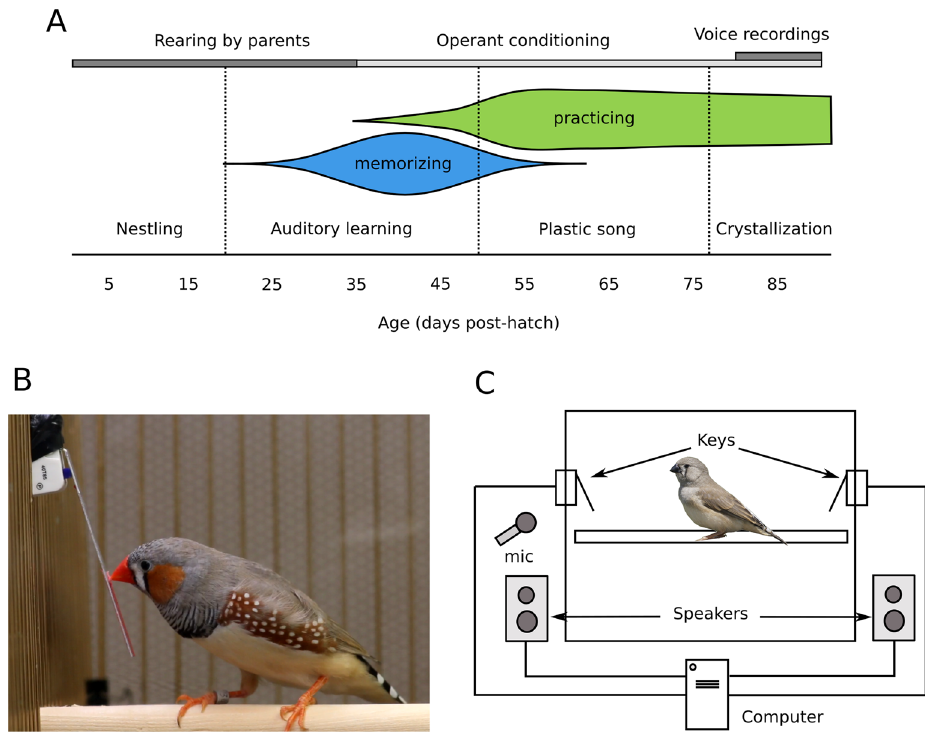
Figure 1. Experimental set-up. ( A ) Experimental timeline (top) and developmental trajectory of song learning in male zebra finches. Zebra finches were reared by their parents in a room where they could also listen to, but not see, adult male zebra finches other than the father (“neighbors”). At 35–37 dph, when finches are nutritionally independent 37 , the juveniles were transferred to an operant chamber equipped with keys that were associated with playback of father’s or neighbor’s song. Preference for father’s or neighbor’s song was measured daily while the bird remained in the operant chamber, until 90 dph. This timeline of operant conditioning covers most of the developmental trajectory of song learning. At the beginning of our assay, at 35–37 dph, zebra finches are still in an auditory phase of learning, during which they are known to memorize adult song 66 and start practicing singing 37 . Singing rates start increasing by age 50 dph. Approximately at the same time, the finches enter the “plastic song” phase 26,27 , during which some memorization may still occur but ends by 65 dph 66 . Finally, song crystallization begins by 77 dph and finishes by 90 dph 26,37 . In the crystallization phase, between 80 and 90 dph, we recorded vocalizations of the juveniles and compared them to father’s and to neighbor’s song. ( B ) An adult zebra finch presses a key in an operant chamber to elicit playback of conspecific song. The same setup was used with the juveniles in our experiment. Photo by CAR-S. ( C ) The operant chamber consisted of a 14 × 15 × 17 inch cage, inside which two keys were placed on opposite walls. One key was associated with playback of father’s song and the other with playback of neighbor’s song. Outside the cage, one speaker assigned to each key played the songs. Photo of finch by Lip Kee Yap, shared under the Creative Commons Attribution- Share Alike 2.0 Generic